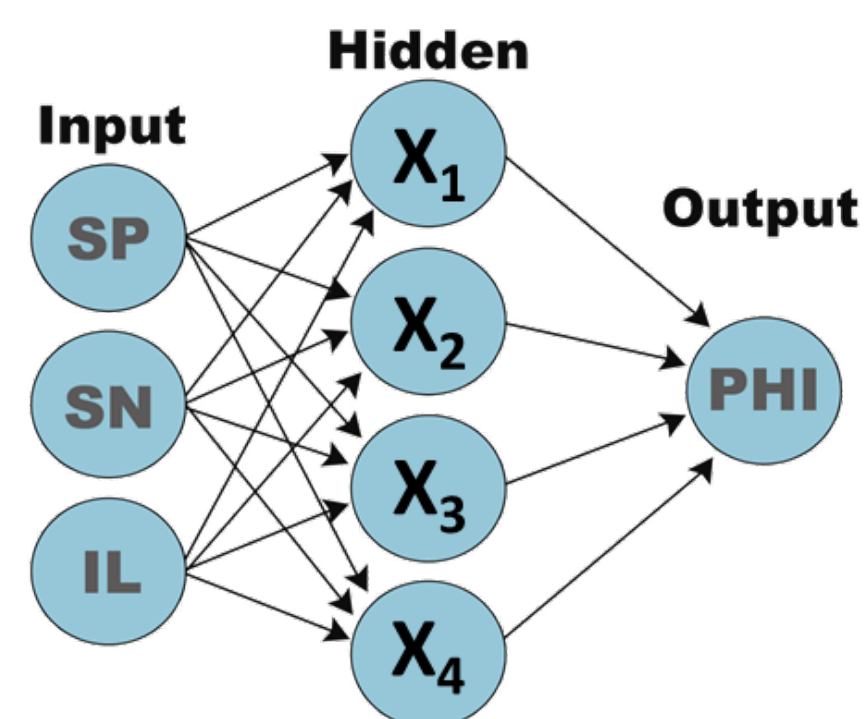
Figure 6. Structure of the Artificial Neural Network with a single input layer containing digitized SP, ILD, and SN values. The inputs are passed into the hidden layer containing four nodes which produce a synthetic porosity (PHI) output.